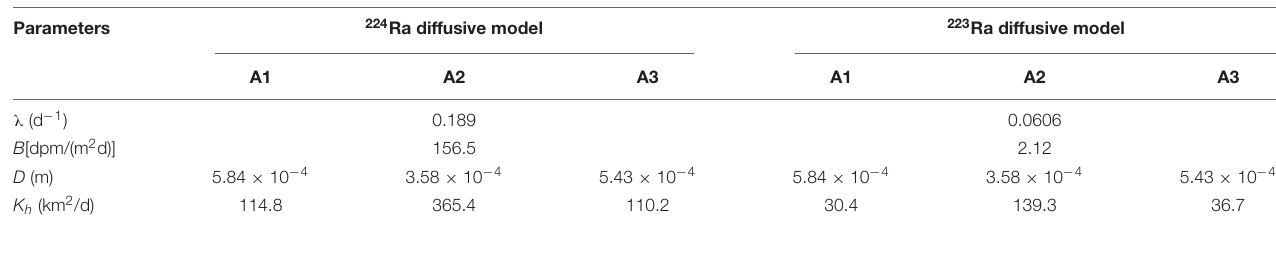
TABLE 1 | Values used in 224 Ra and 223 Ra advection-diffusion equation.